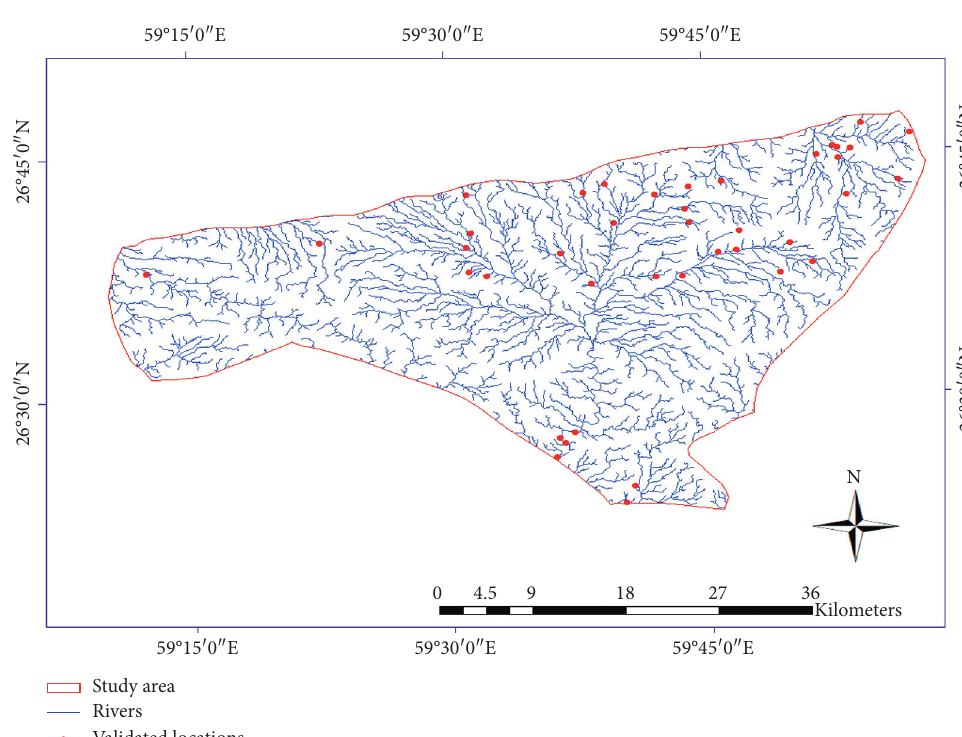
Figure 13: Validated locations in the study area using GPS.